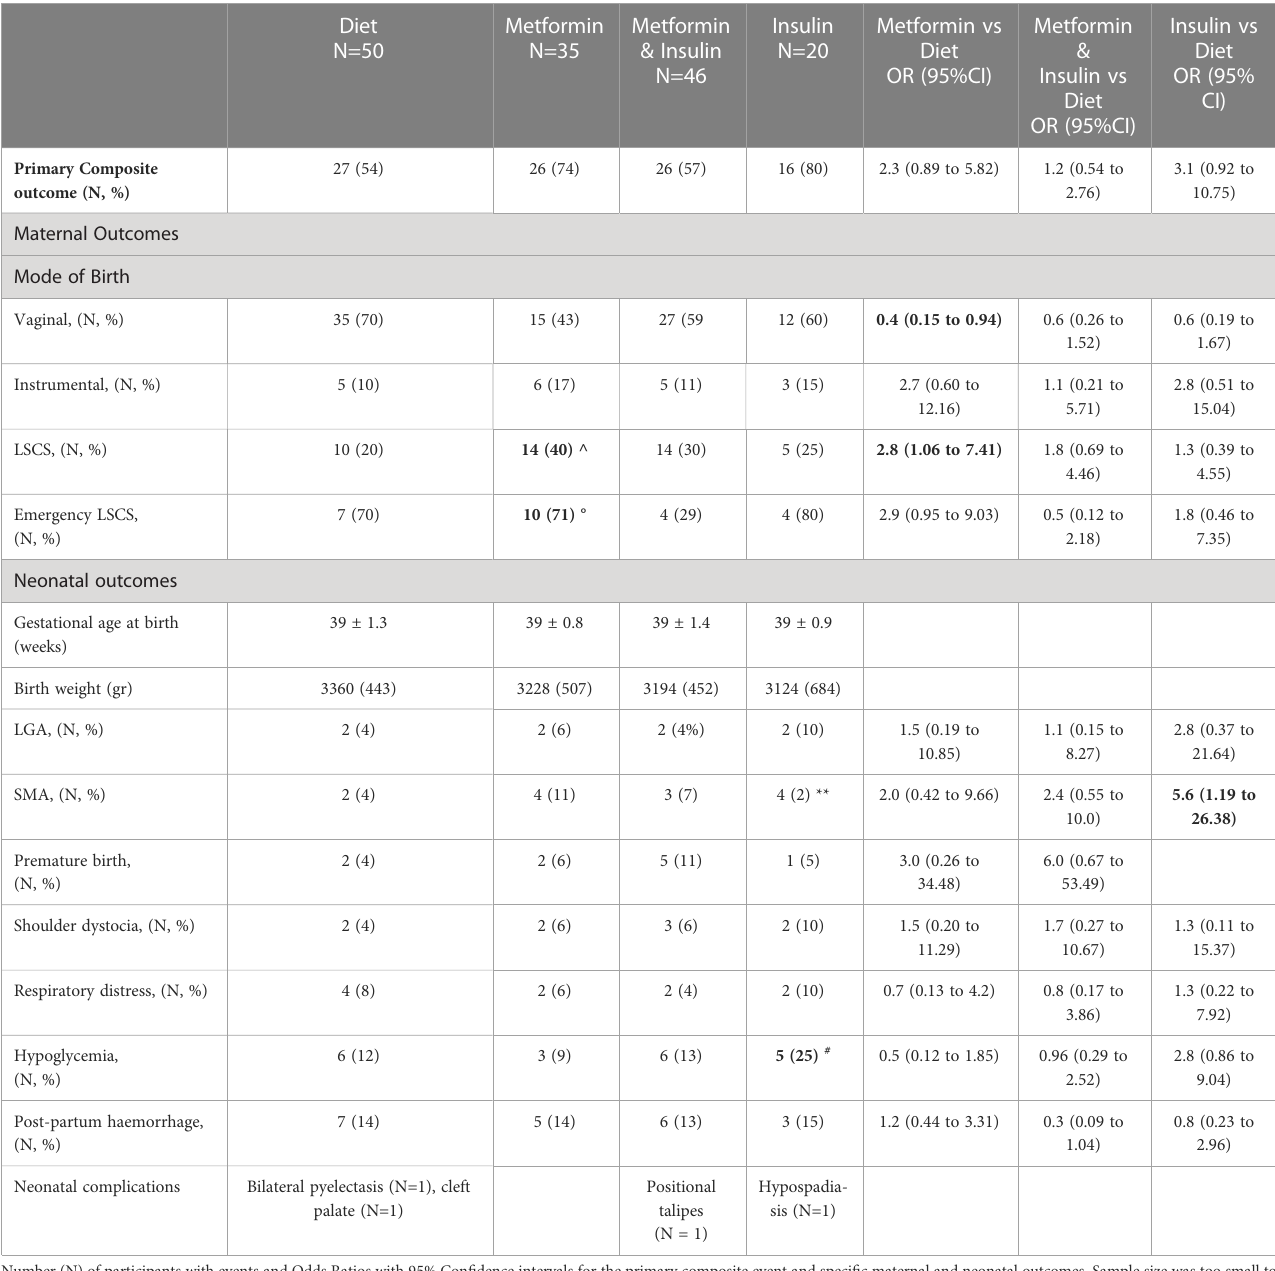
TABLE 2 Maternal and neonatal outcomes of study